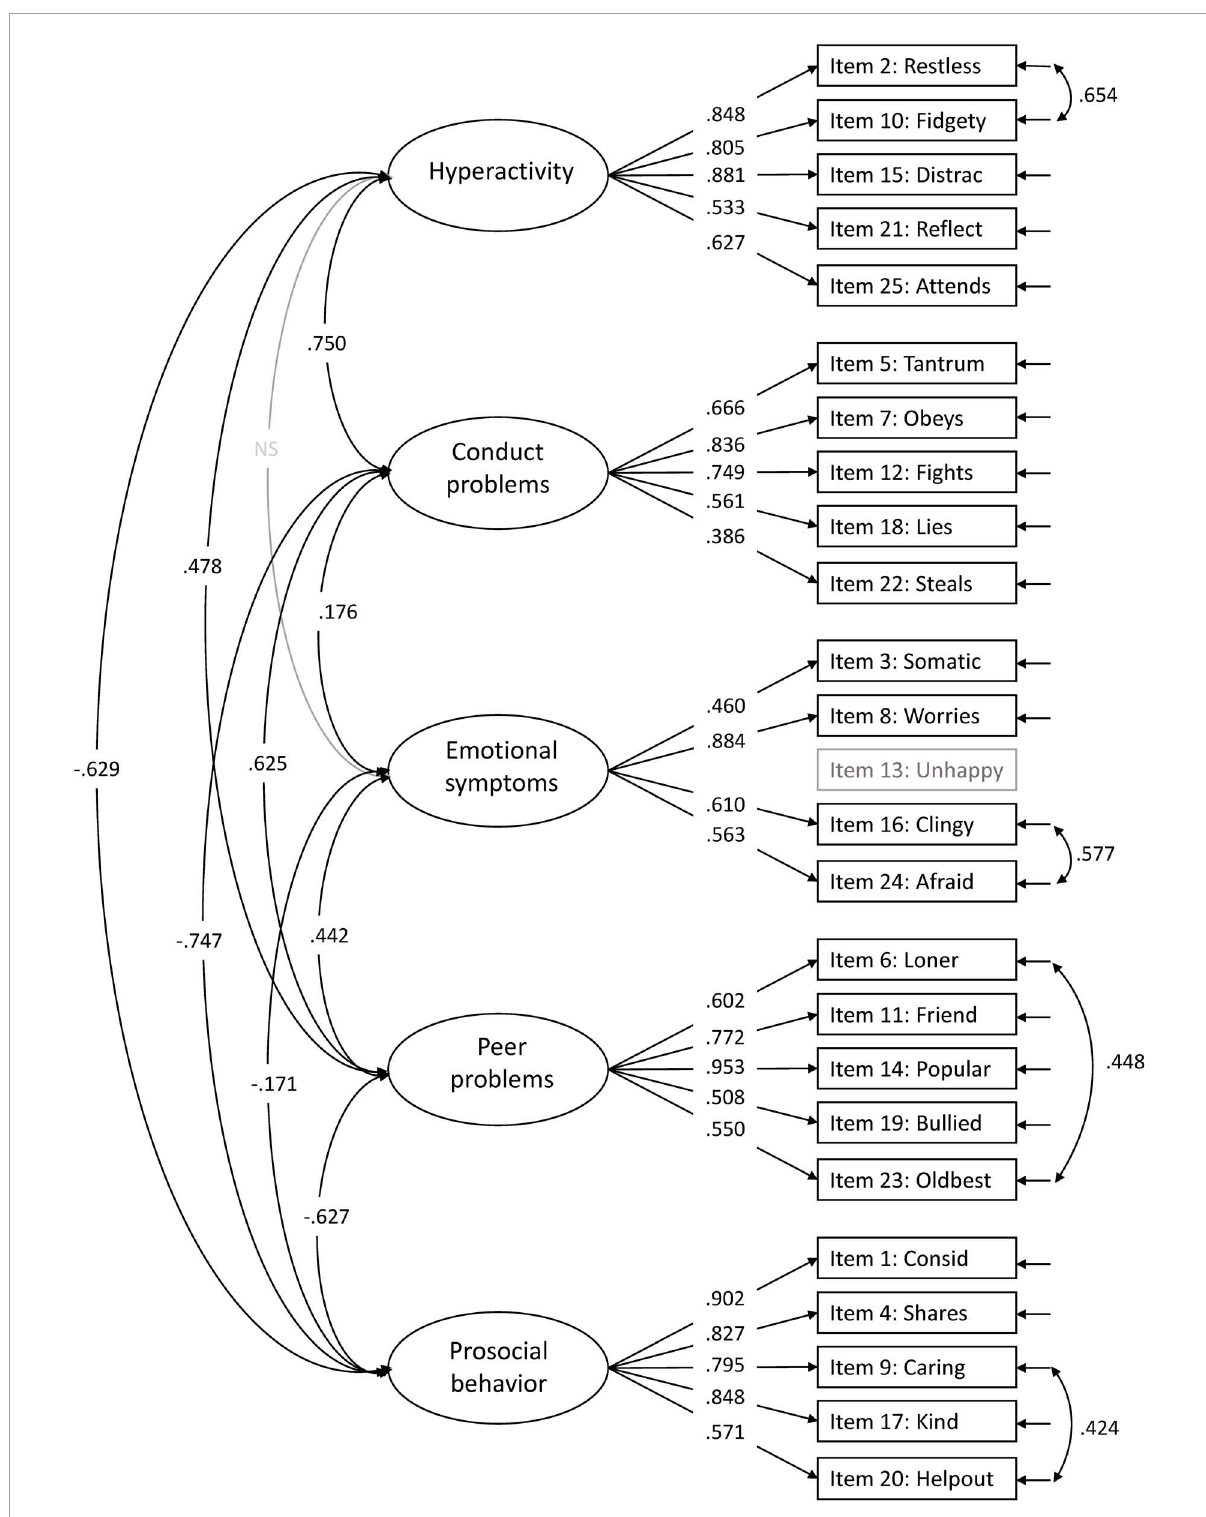
FIGURE7 Accepted five-factor model (Model 1). All paths are significant unless marked non significant (NS). Item 13 is not included in the confirmatory factor analysis